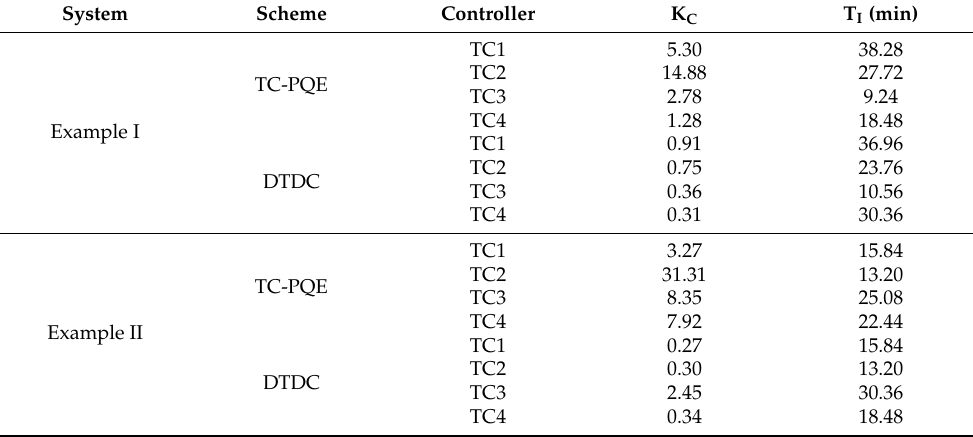
Table 3. Controller parameters of the DTDC and TC-PQE schemes (Examples I and